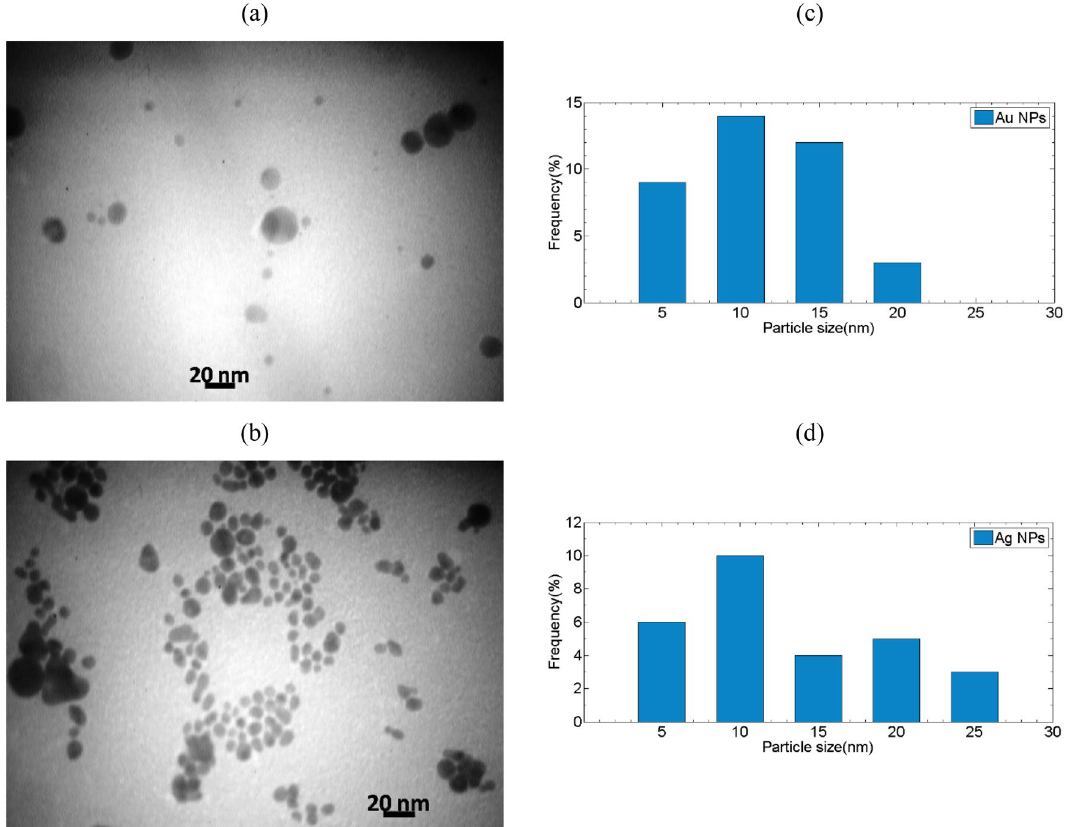
Fig. 6 Representative TEM images of AuNPs a and AgNPs b . c and d histogram showing the average size of AuNPs and AgNPs,